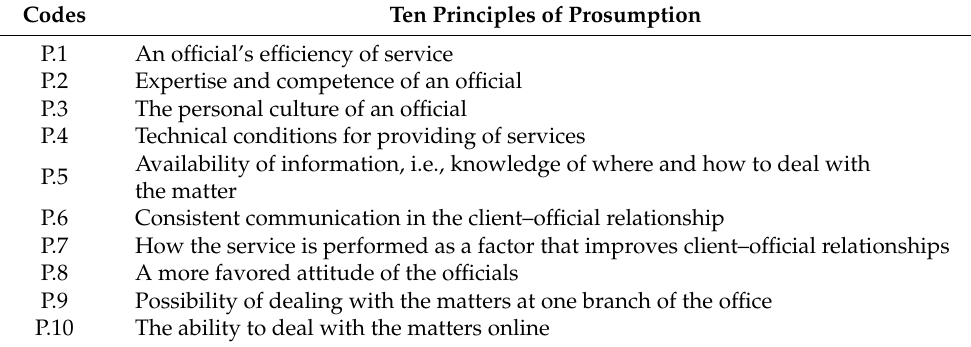
Table 1. The principles of